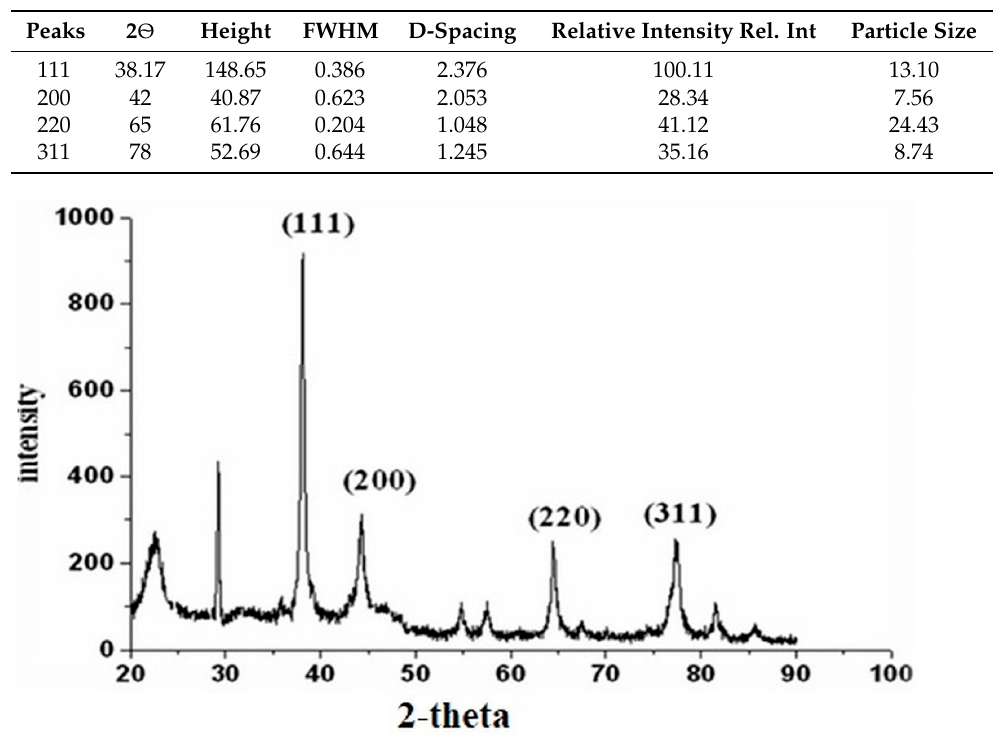
Figure 3. X-ray diffraction pattern of synthesized silver nanoparticles of Elaeagnus umbellata fruit extract.